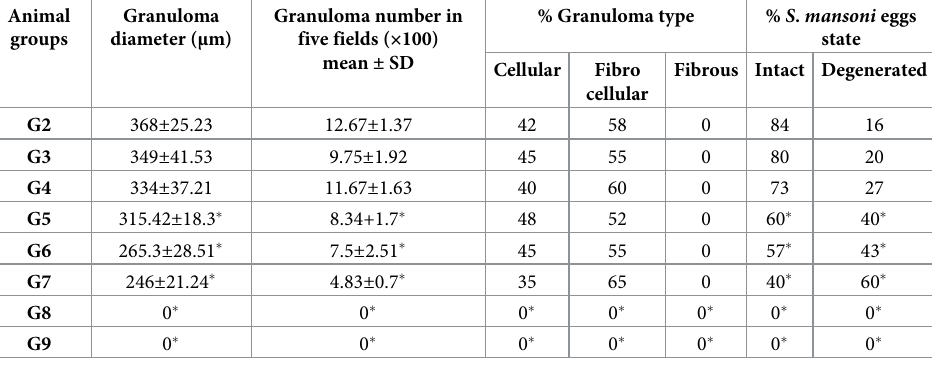
0 � 0 � � P value < 0.05. Values are given as mean ± SD for 4 mice in each group. G2; infected non-treated, G3; prophylaxis by GNPs then infected, G4; infected-treated with ginger extract, G5; infected-treated with GNPs, G6; infected-treated with PZQ, G7; infected-treated with 1/2 dose GNPs + 1/2 dose PZQ, G8; infected-treated with MFQ, and G9; infected-treated with 1/2 dose GNPs + 1/2 dose MFQ.